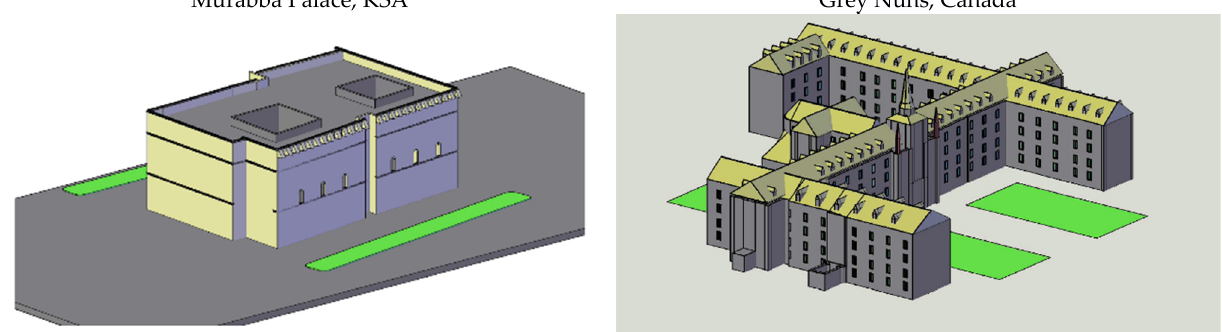
Figure 4. BIM model development of MP and GN.